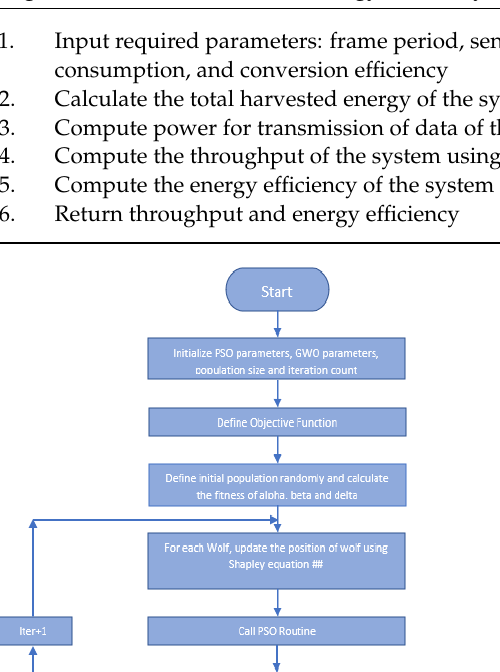
Algorithm 2: Evaluate Fitness Energy Efficiency (EE) and Throughput